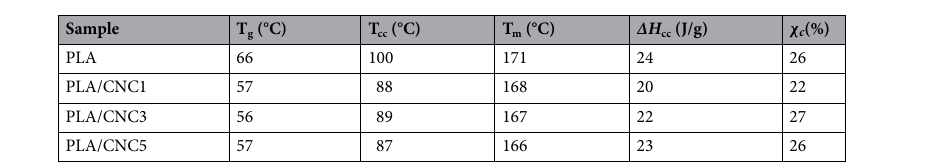
Table 1. Glass transition temperature (Tg), cold crystallization temperature (Tcc), melt temperature (Tm), cold crystallization enthalpy ( ∆H cc)) and degree of crystallinity ( χ c ) for PLA and PLA/CNCx composites from